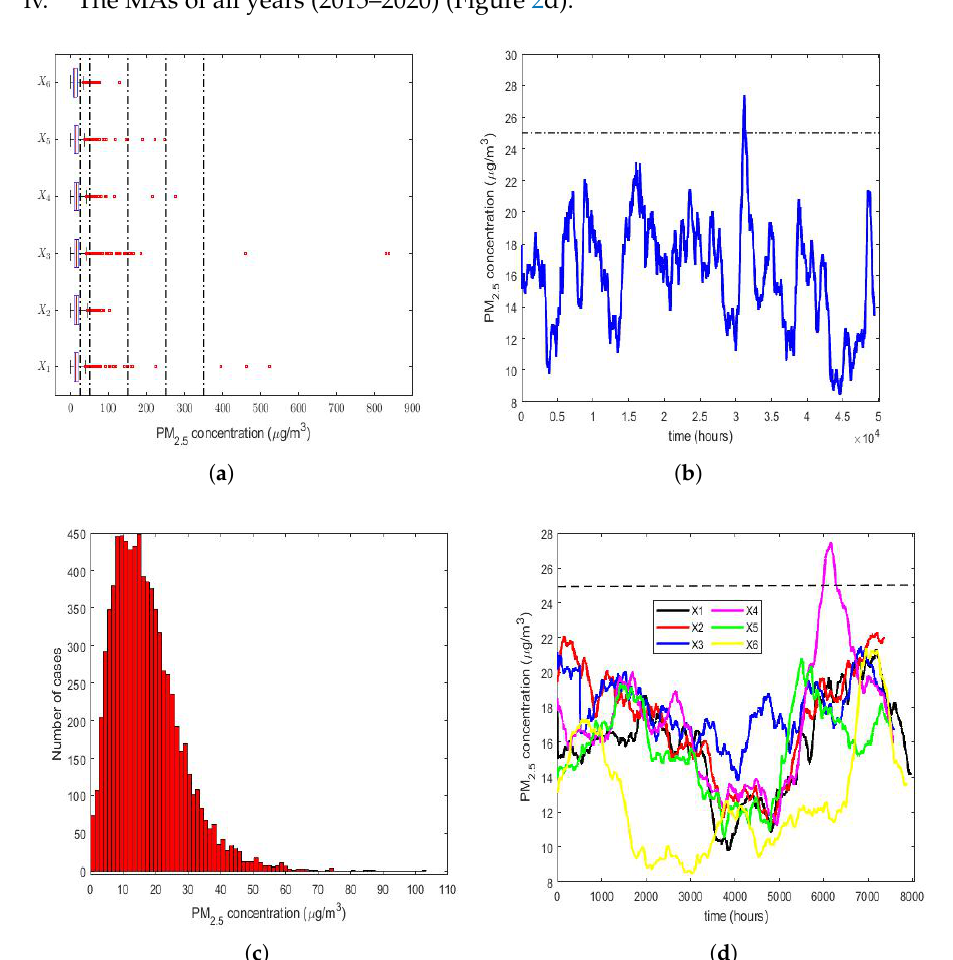
Figure 2. Box plot of each variable, moving average of the time series consisting of all observations, histogram of the year 2016, and moving average of each variable. The outliers are represented by red circles, and the dashed lines (5 vertical dashed lines in ( a ) and 1 horizontal dashed line in ( b , d )) indicate intervals of air pollution levels: desirable level [0, 25 µg/m 3 ), acceptable level [25 µg/m 3 , 50 µg/m 3 ), caution level [50 µg/m 3 , 150 µg/m 3 ), alert level [150 µg/m 3 , 250 µg/m 3 ), alarm level [250 µg/m 3 , 350 µg/m 3 ), and emergency level [350 µg/m 3 , ∞ ). ( a ) Multiple box plots: X 1 (2015), . . ., X 6 (2020). ( b ) Moving average of all observations from 1 January 2015 to 31 December 2020. ( c ) Histogram of the year 2016 ( X 2 ). ( d ) Moving average of each variable: X 1 (2015), . . ., X 6